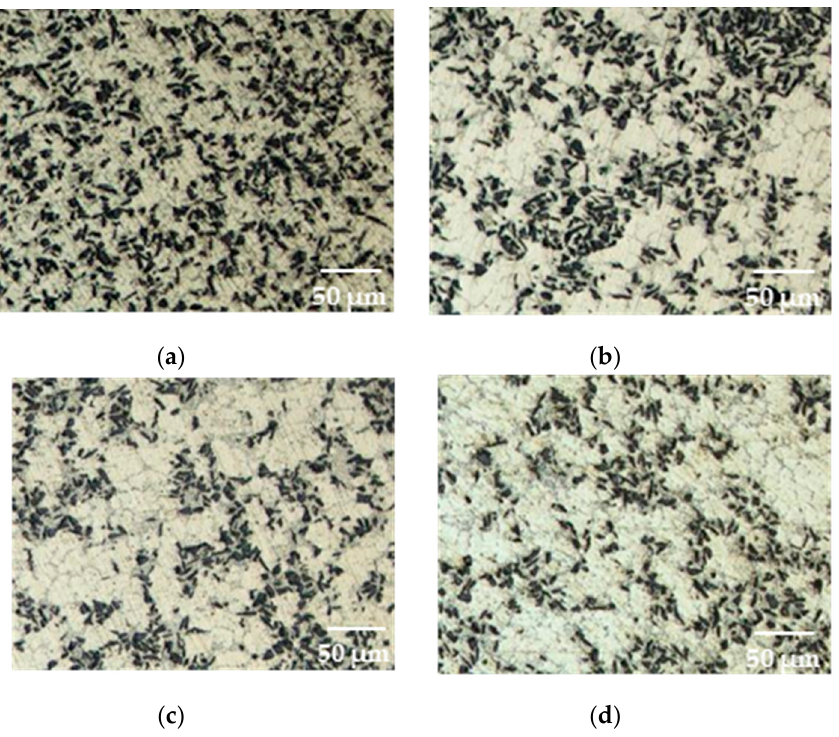
Figure 14. Cross - sectional microstructures of rheo - die-cast A356 / SiC ( 15%SiC - 15µm ) at Speed = 4 m / s and Pressure = 12 MPa in ( a ) position no . 1; ( b ) position no . 2; ( c ) position no . 3; and ( d ) position no . 4 .